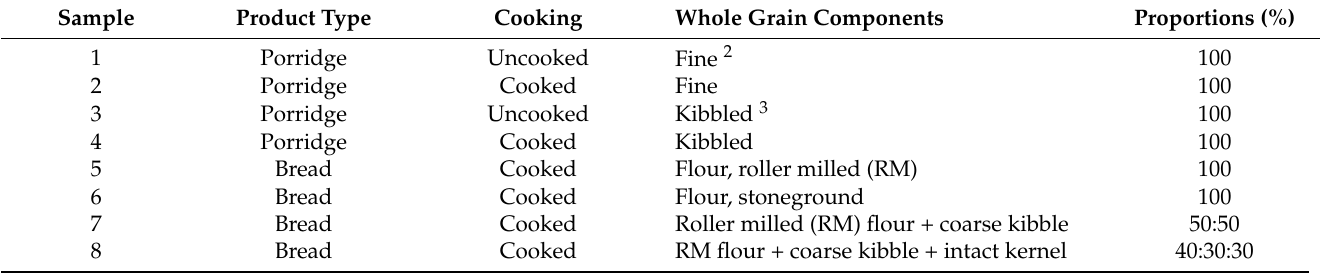
Table 1. Samples of wholegrain wheat products supplied for in vitro glycaemic impact analysis 1 .